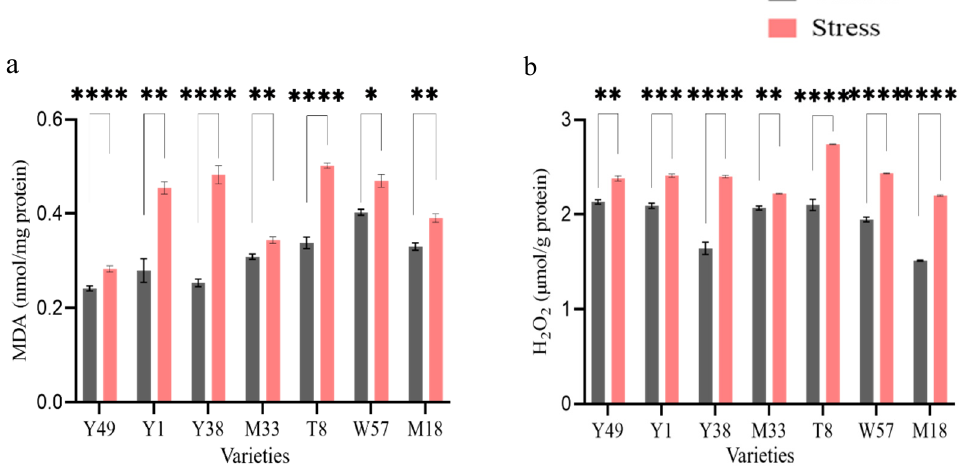
Figure 1. Influence of cold stress on leaf antioxidant and enzymatic antioxidants in jute varieties. Plant under control (28 °C) and stress (5 °C) showed a response in: ( a ) Lipid peroxidation MDA, ( b ) Hydrogen peroxide (H 2 O 2 ). Different significant level marked with **** p < 0.0001, *** p ≤ 0.001, ** p ≤ 0.01, * p ≤ 0.05, and ns mean non-significant.